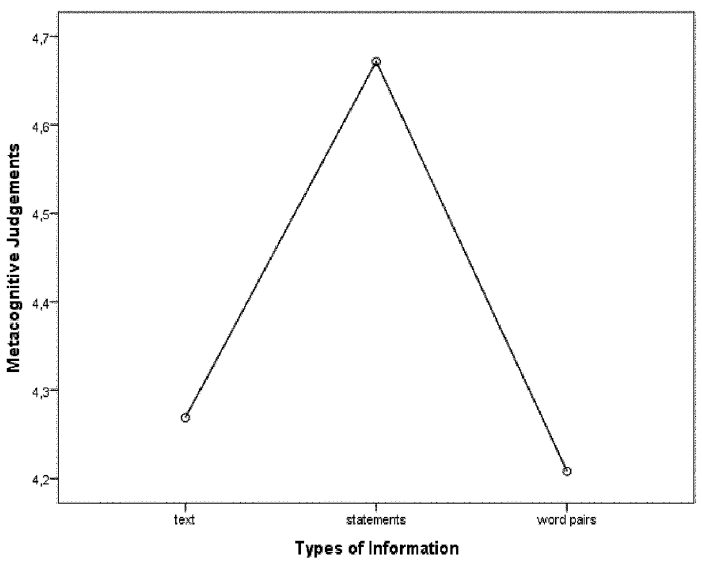
Figure 2. Performance rankings of metacognitive judgements in terms of the type of